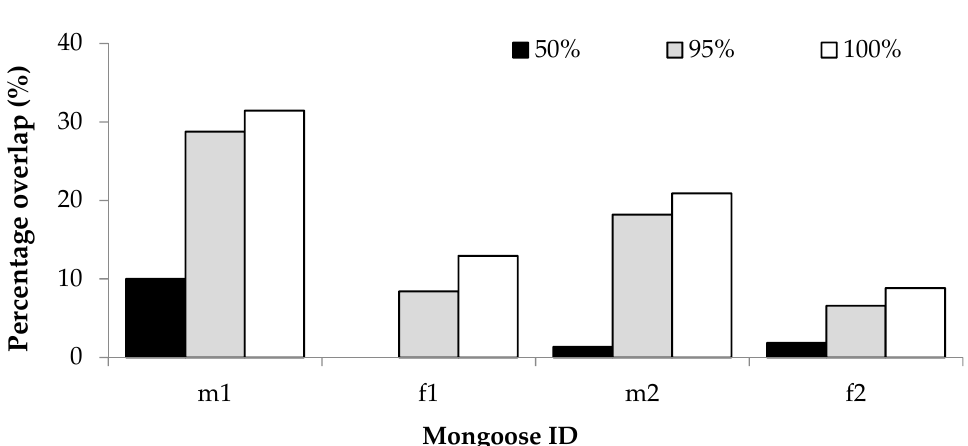
Figure 4. Percentage GPS location overlap with human residential gardens of two male (m1, m2) and two female (f1, f2) yellow mongooses for different home range isopleth levels in the Meyersdal estate.